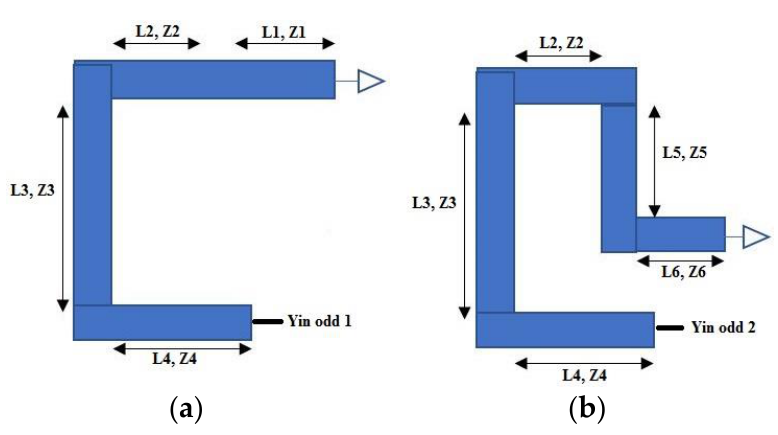
Figure 10. ( a ) First odd-mode excitation circuit. ( b ) Second odd-mode excitation